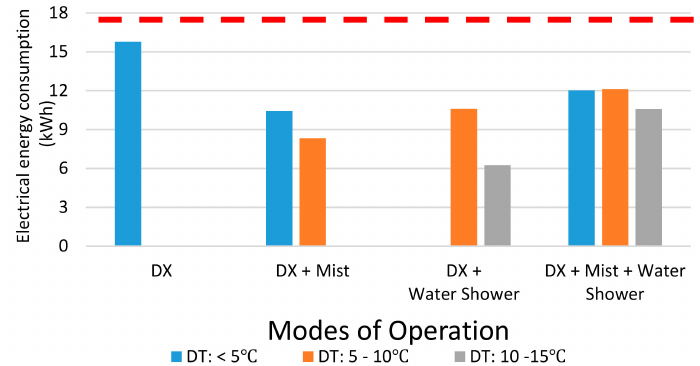
Figure 8. Electrical energy consumption of various modes of operation of the fresh-air-handling unit (FAHU) for di ff erent ranges of ∆ T HX in ambient temperatures less than 40 ◦ C.